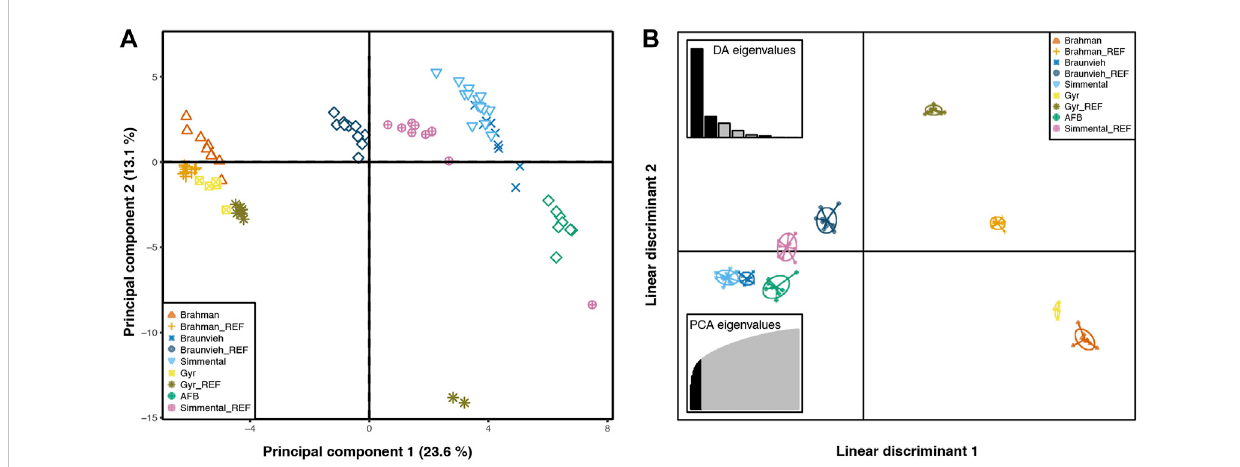
FIGURE 2 Principal component analysis (PCA) and Discriminant analysis of principal components (DAPC) plots. Samples belong to a reproductive cattle herd that comprises with Brahman ( N = 9), Braunvieh ( N = 9), Gyr ( N = 5), and Simmental ( N = 15) breeds; a locally adapted creole cattle, the Arequipa Fighting Bull (AFB, N = 9); and 40 genotype samples from reference breeds included in the analyses (subscript with _REF). Symbols and colors indicate breed af fi liation, each symbol represents an individual. (A) . For PCA plot, the x- and y-axes are indicated by the fi rst and second components, respectively, and the values in parentheses show the percentages of total variance explained. (B) . For DAPC plot, the scatterplot shows only the fi rst two linear discriminants of the analysis.